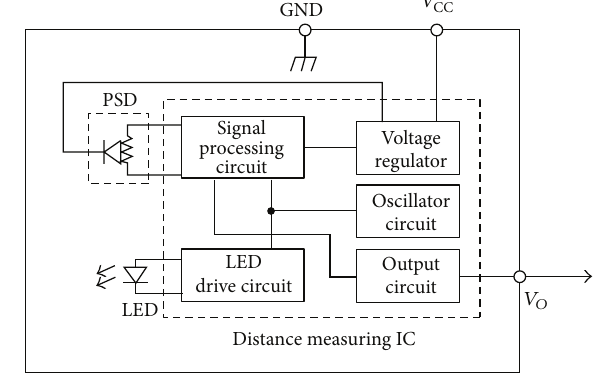
Figure 3: The block diagram of IR Sensor.